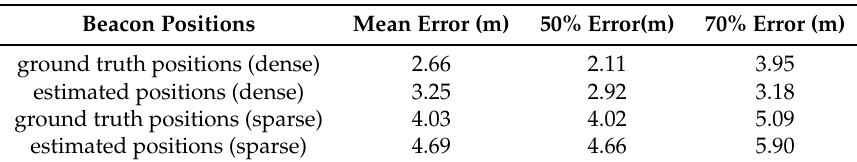
Table 4. Error statistics of range-based positioning using ground truth beacon positions and estimated beacon positions.